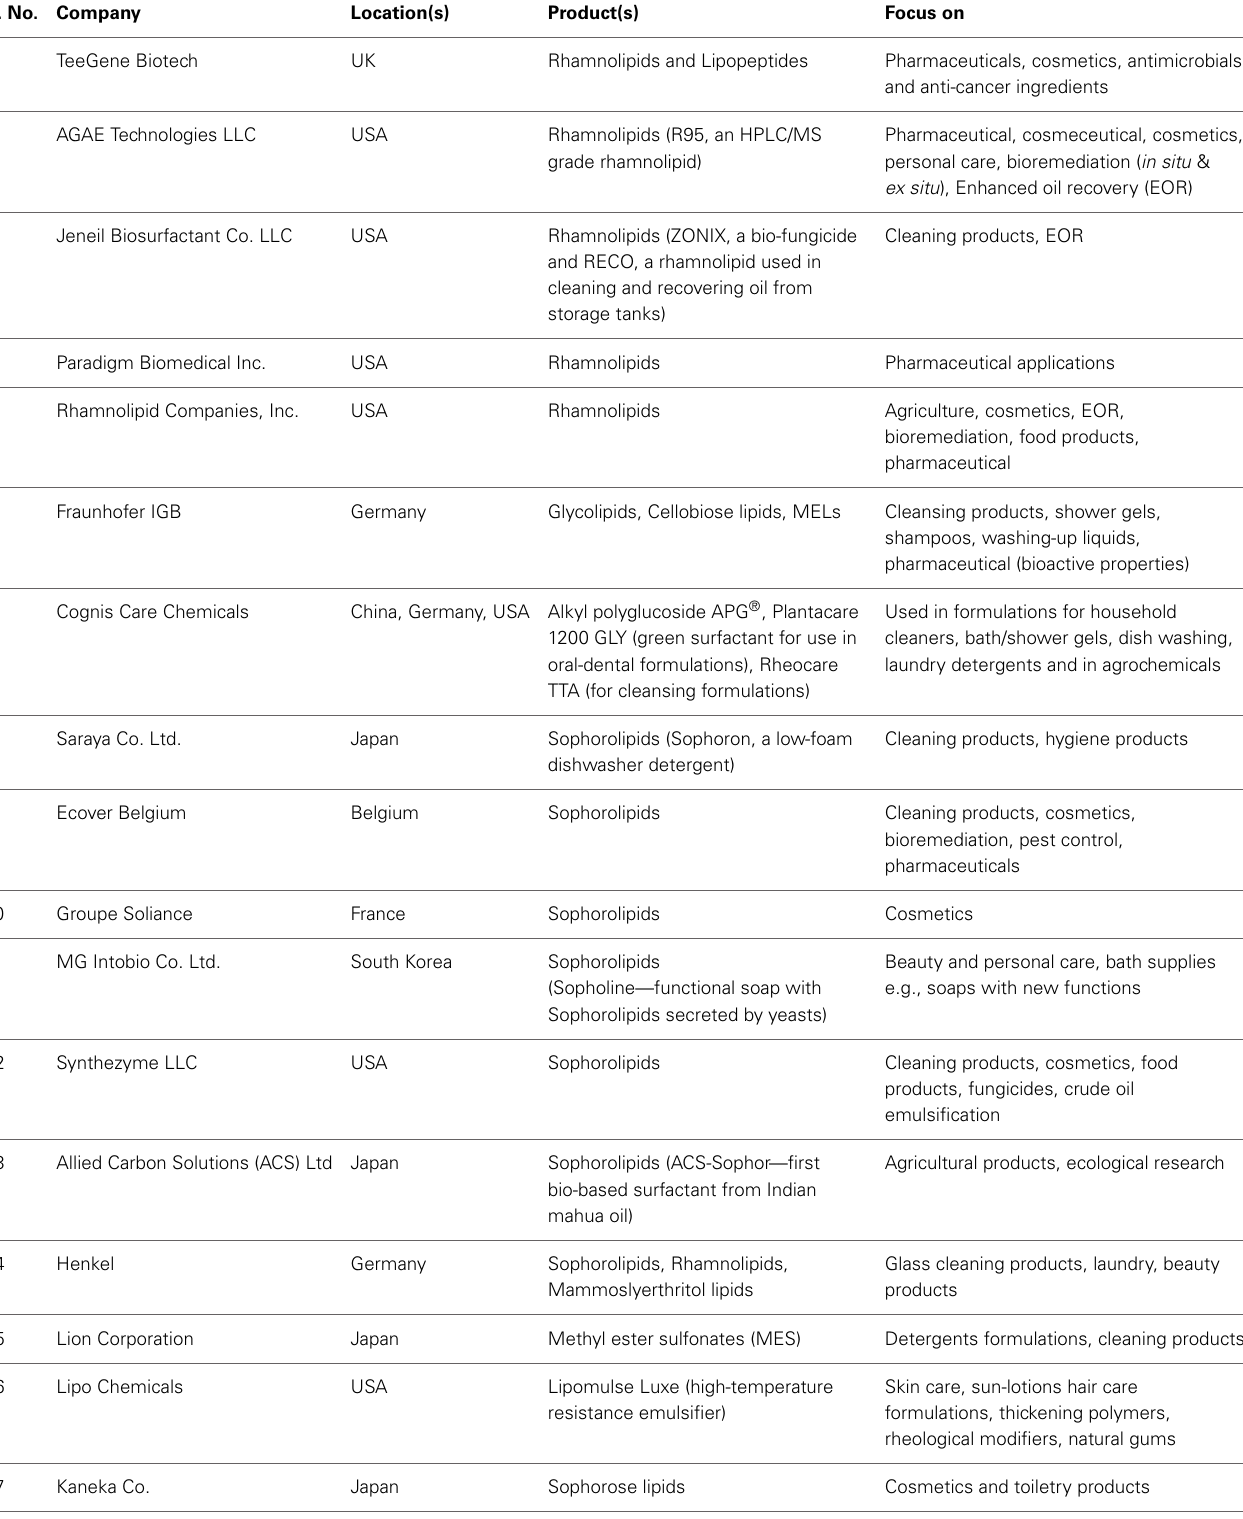
Table 1 | Biosurfactant producing companies around the